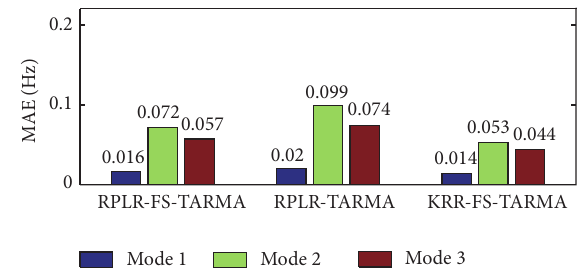
Figure 8: Monte Carlo comparison of different methods: MAE of natural frequency